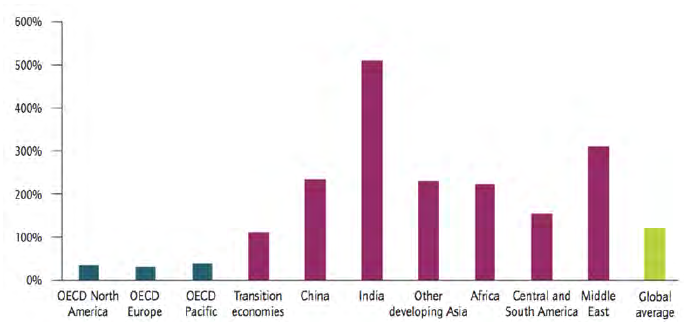
Figure 4. Projected electricity consumption growth, 2007–2050 (international Energy Agency,